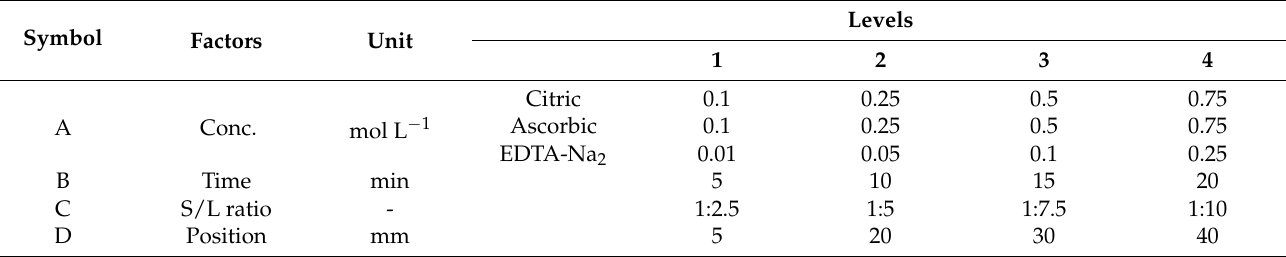
Table 5. Factors and levels used in the experiments.